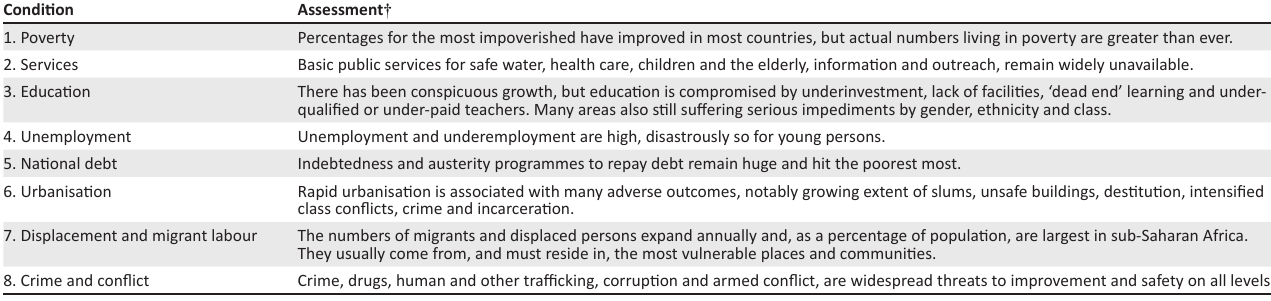
TABLE 1: Concerns and trends of the past two decades that undermine development in developing countries, or show its failures.